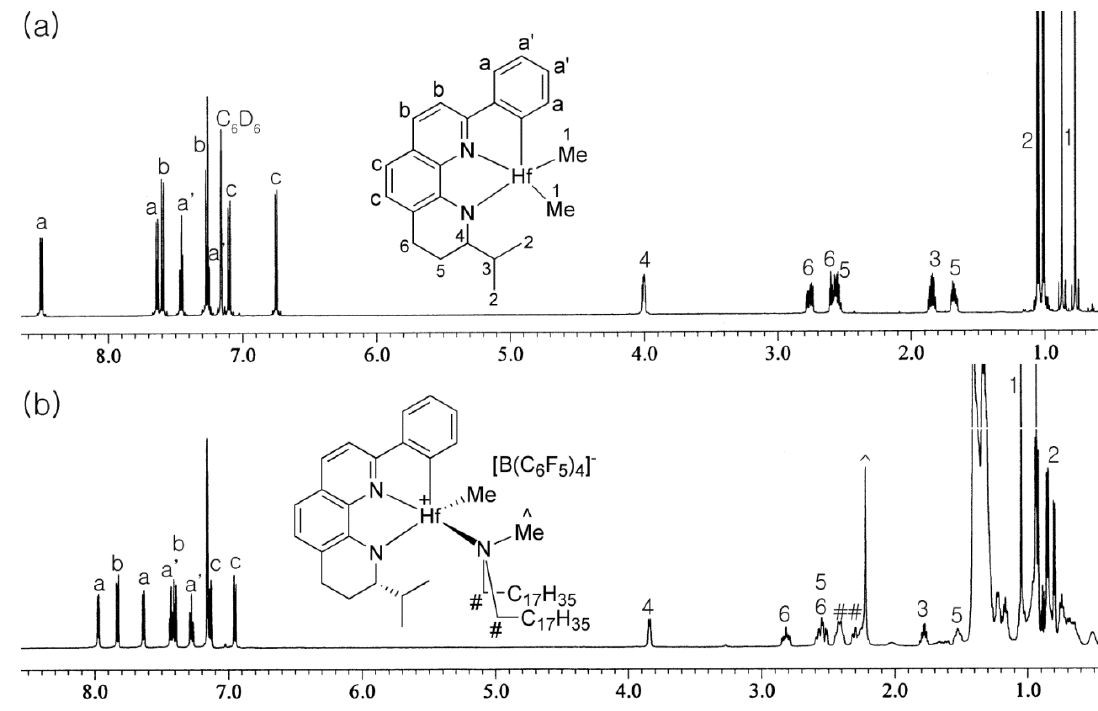
Figure 1. 1 H NMR spectra of 12 ( a ) and its activated complex ( b ).